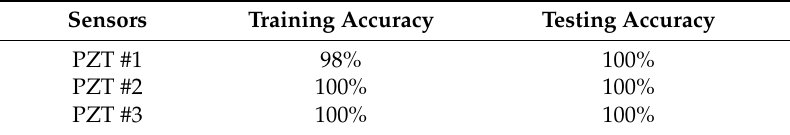
Table 2. Results for the CNN method: training and testing phases.